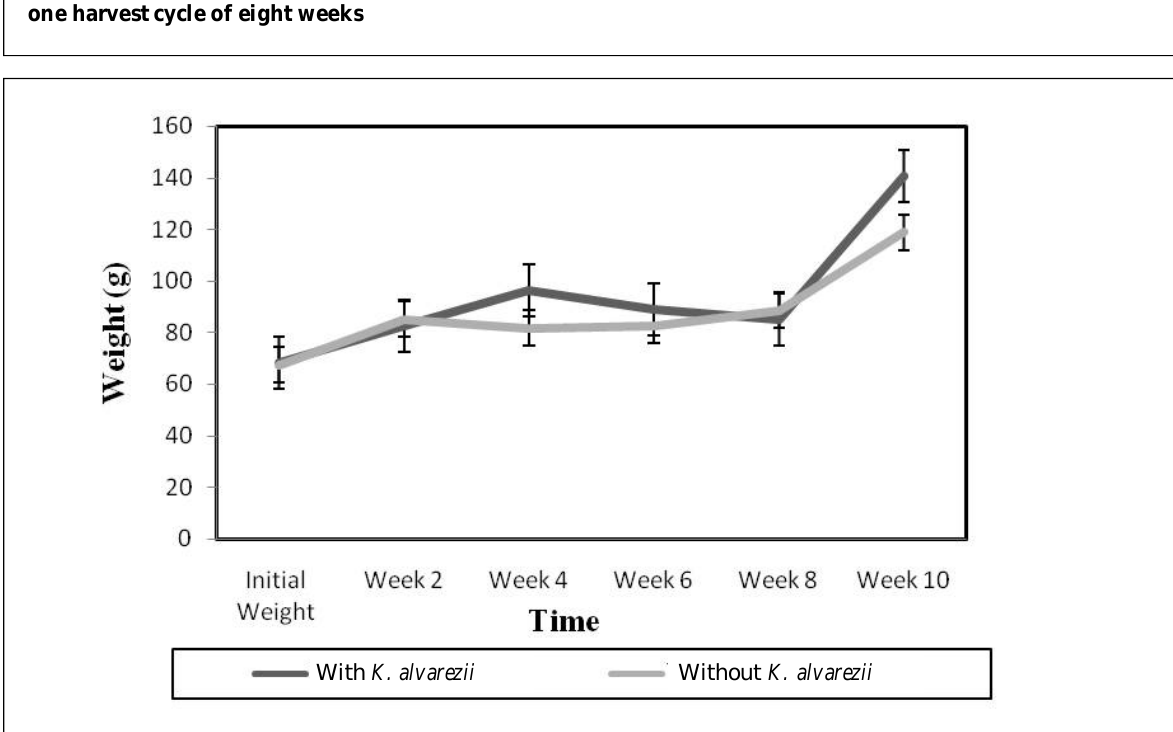
Figure 4: Comparison of average (± SD) weight gain of H. scabra co-cultured with K. alvarezii and H. scabra cultured in pens without K.